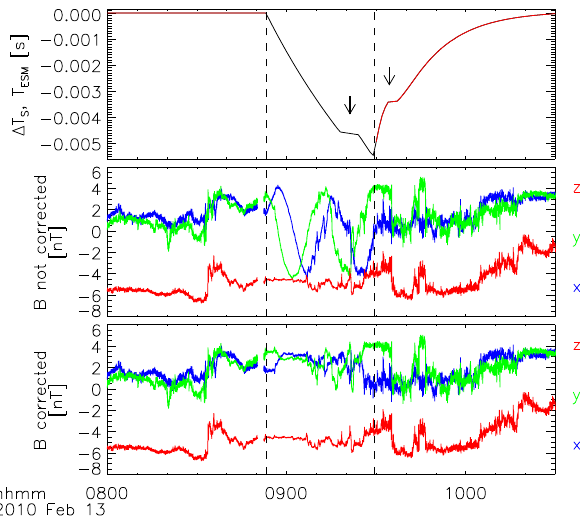
Fig. 6. ES model application for a THEMIS B lunar-flyby, 13 February 2010. Top panel: spin period differences to T S ref , mid panel: Magnetic field despun with uncorrected spin times, bottom panel: magnetic field B despun with corrected spin-times using the ESM. The eclipse time interval is delimited by the dashed